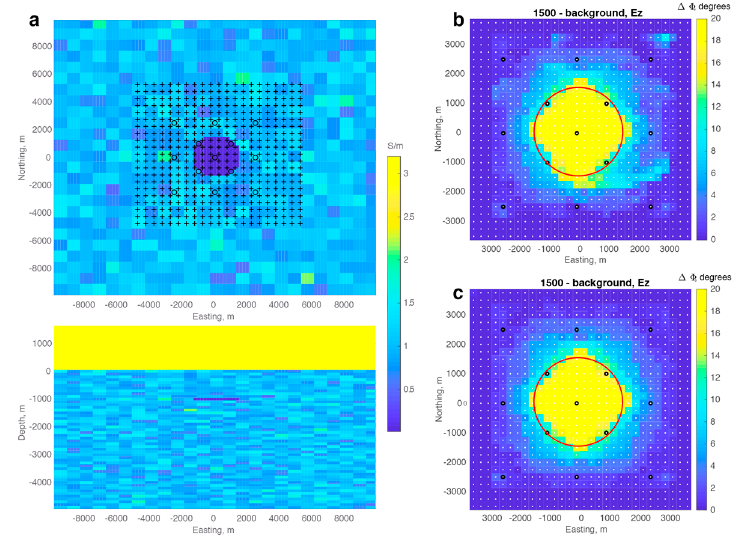
Figure 4. Simulation of the 1500 m radius reservoir in a heterogenous background geology. ( a ) Model conductivity structure. ( b ) The 1500 m response in a uniform background as shown in Figure 2. ( c ) The response in the heterogeneous background.